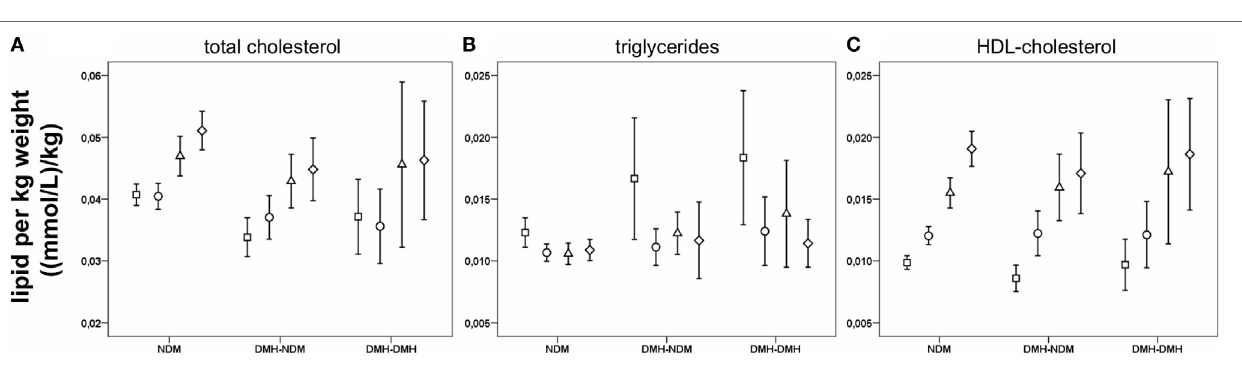
FigUre 4 | Lipids per kilogram bodyweight before and after Roux-en-Y gastric bypass (RYGB) surgery. Figure show mean and a 95% confidence interval of the mean before surgery and at 3, 6, and 12 months after RYGB for the whole patient population for total cholesterol (a) , triglycerides (B) and HDL-cholesterol (c) .